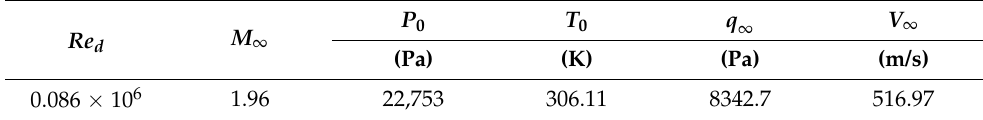
Table 2. Flow condition based on AEDC wind tunnel test report.